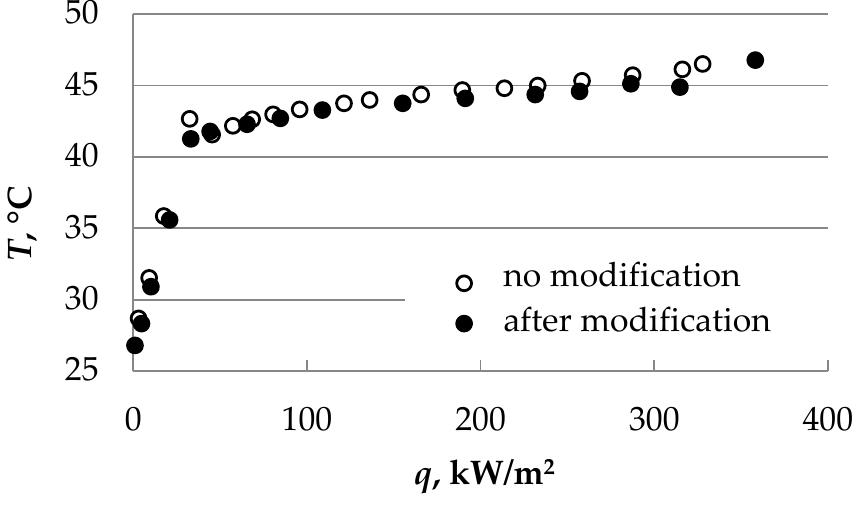
Figure 5. Wall temperature in the T4 thermocouple section versus heat flux density.